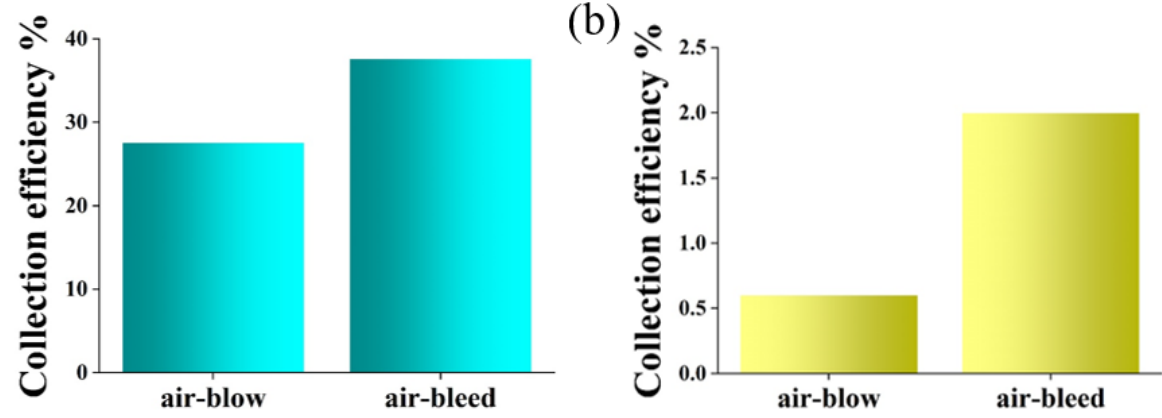
Figure 12. Comparison of collection efficiency with “gas-blow” and “gas-bleed” gas introduction methods: ( a ) droplet charge number q ave = 1.57 × 10 − 14 C; ( b ) droplet charge number q R = 6.06 × 10 − 13